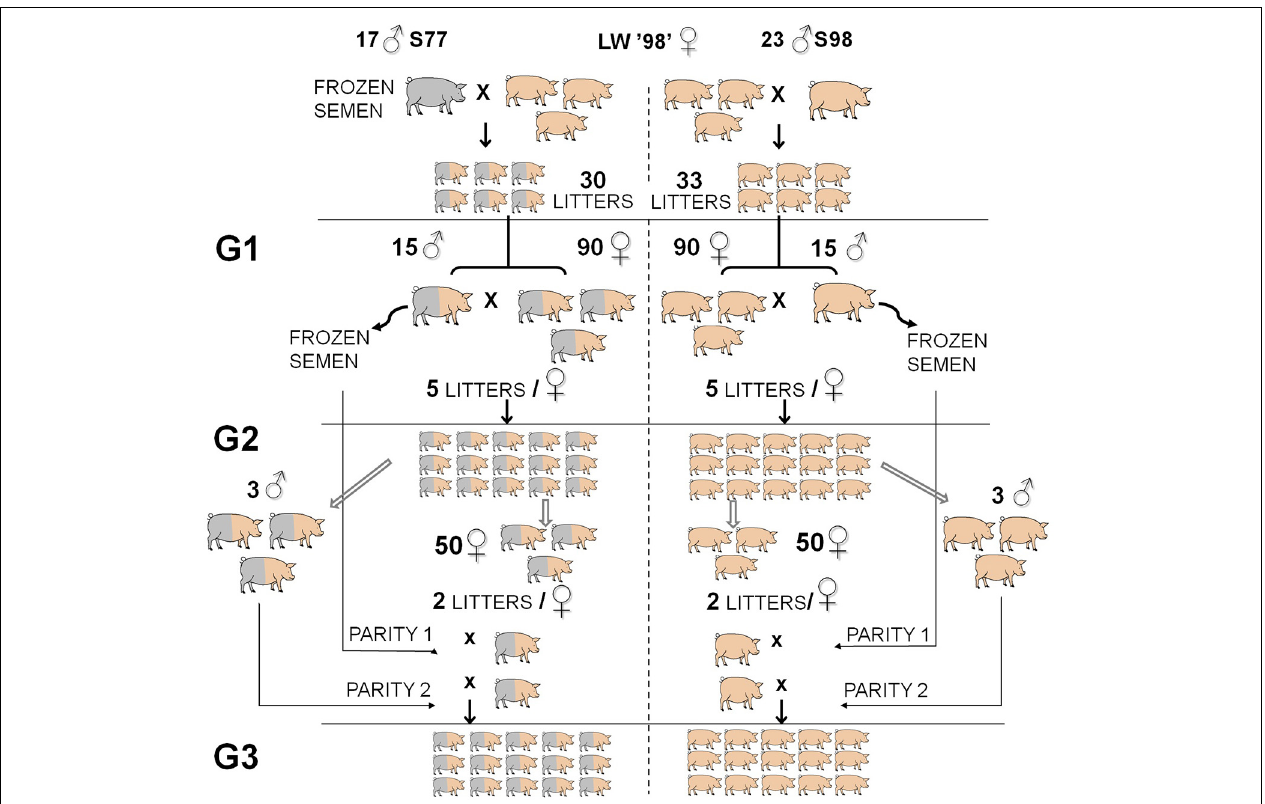
FIGURE 1 | Overview of the experimental design developed to estimate genetic trends from 1977 to 1998 in the French Large White dam population. Phenotyping of the maternal performance of old-type